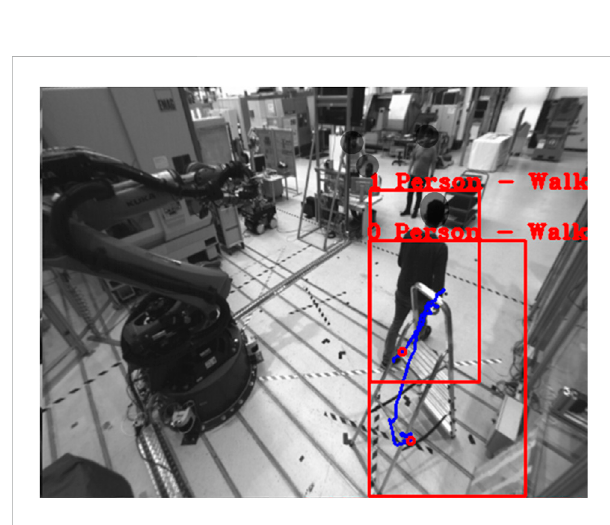
FIGURE 10 Ladderisrecognizedasapersoniftheboundingboxincludesthe